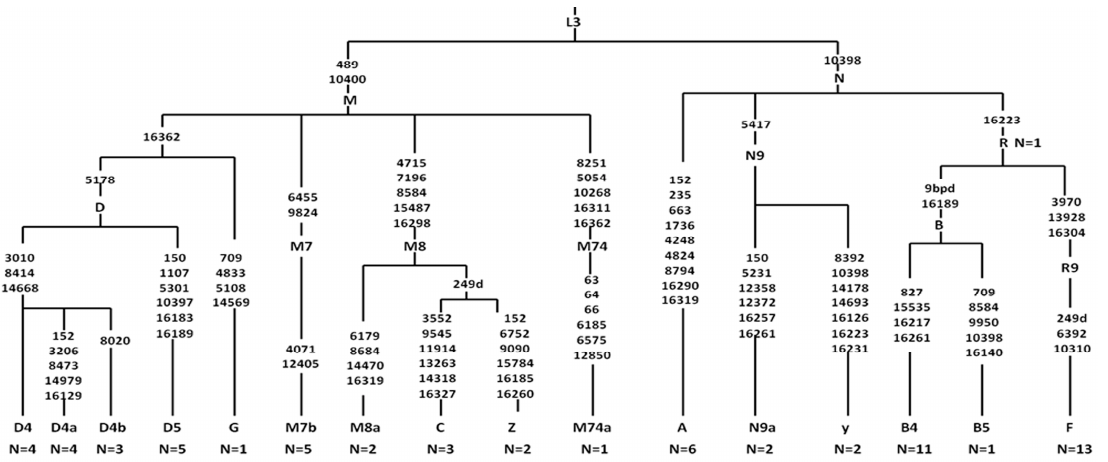
Figure 4. Phylogenetic tree was constructed to reveal the underlying lineages of 16 mtDNA haplogroups in 66 PTC cases.